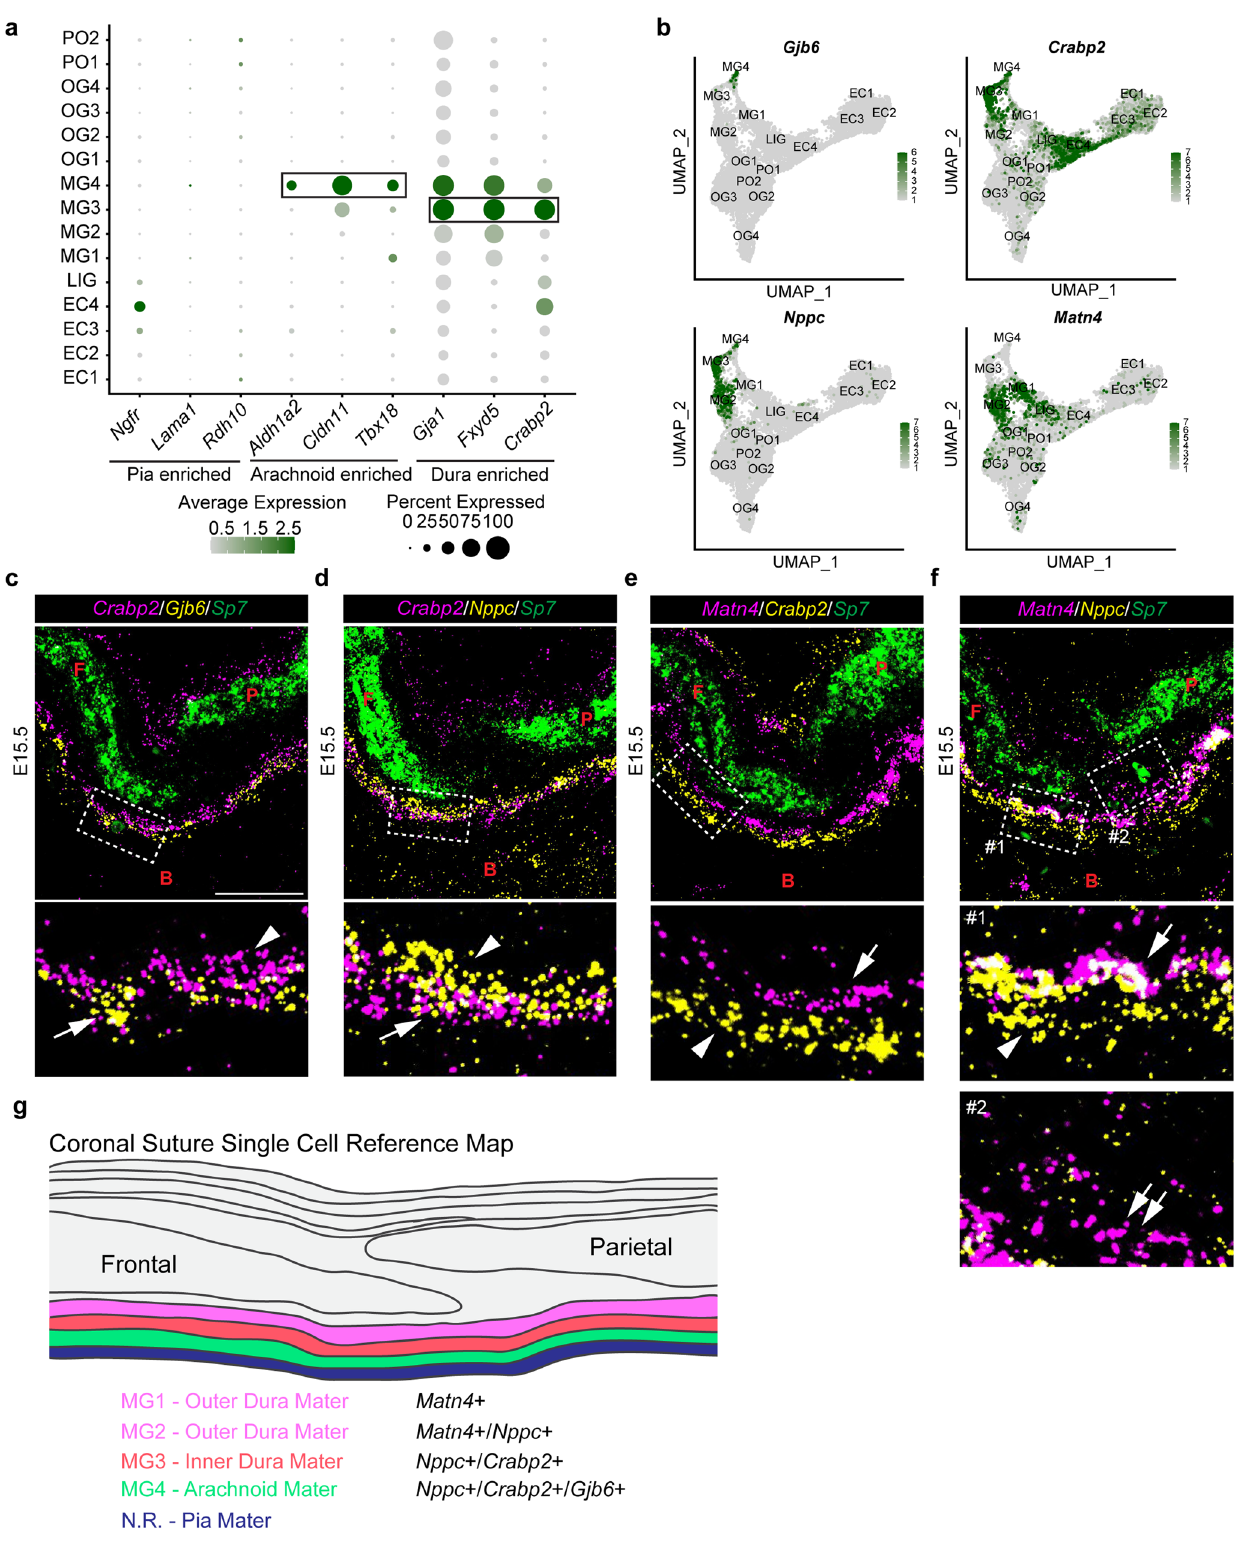
Fig. 2 Diverse meningeal cell types are resolved by scRNA-seq. a Dot plot depicting selected markers previously associated with the pia mater, the arachnoid, and the dura mater. b Feature plots of genes validated by in situ experiments. c – f Combinatorial in situ analysis of coronal sutures for indicated markers at E15.5. Sp7 marks the frontal (F) and parietal (P) bones, except for insets (boxed regions) below. c Crabp2 and Gjb6 . Arrow, Crabp2 + / Gjb6 + ; arrowhead, Crabp2 + . d Crabp2 and Nppc . Arrow, Crabp2 + / Nppc + ; arrowhead, Nppc + . e Matn4 and Crabp2 . Arrow, Matn4 + ; arrowhead, Crabp2 + . f Matn4 and Nppc . Arrow, Matn4 + /Nppc + ; arrowhead, Nppc + ; double arrows, Matn4 + . g Model summarizing gene expression patterns of meningeal layers captured from single-cell analysis. B, Brain. In situs were performed in biological triplicate. Scale bar = 50 µ m; the upper panels in ( c – f ) are at the same magni fi